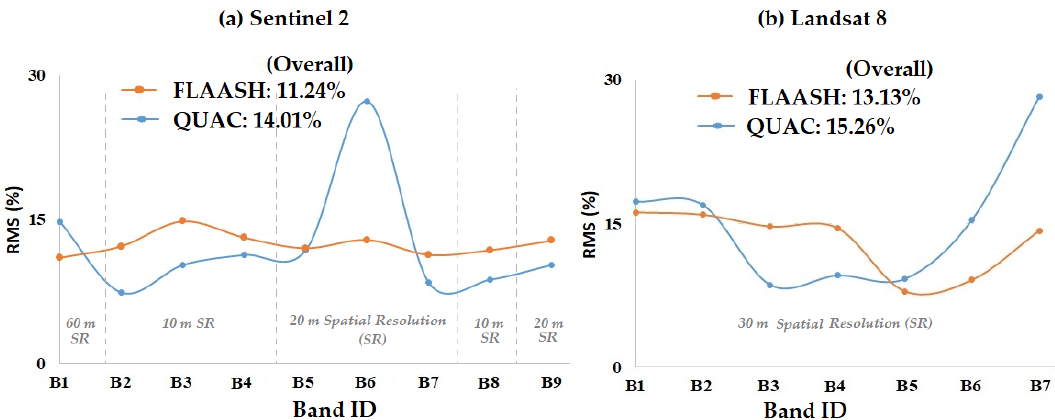
Figure 3. Atmospheric correction analysis (RMS %) for each band ( a ) Sentinel and ( b ) Landsat